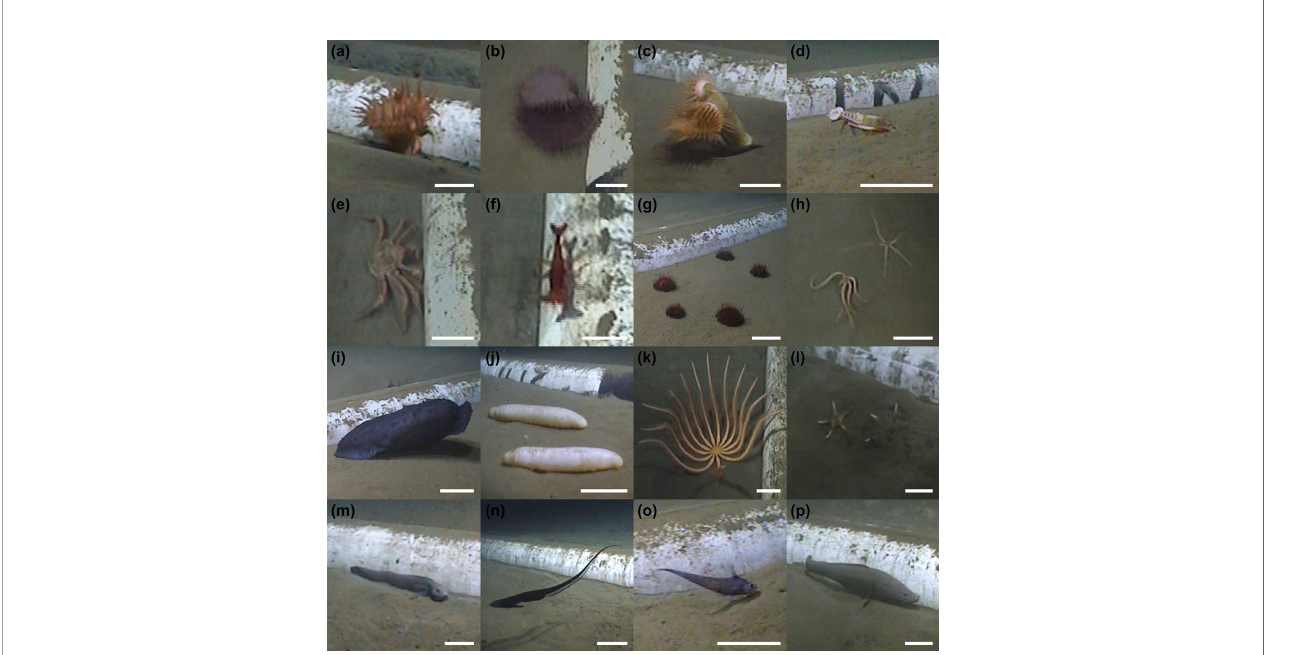
FIGURE 4 | Selected morphotypes visible in survey. (A) Actinostolidae gen. indet.; (B) Actinoscyphia sp. indet. 1; (C) Actinoscyphia sp. indet. 2; (D) Polycheles sp. indet. 1; (E) Lithodidae stet.; (F) Decapoda natant fam. indet. 2; (G) Phormosoma sp. indet.; (H) Ophiuroidea ord. indet.; (I) Benthothuria sp. indet. 1; (J) Holothuroidea ord. indet. 4; (K) Brisingida stet.; (L) Asteroidea ord. indet. 2; (M) Pachycara sp. indet.; (N) Eurypharynx sp. indet. 1; (O) Macrouridae gen. indet. 3; (P) Bythitidae stet.